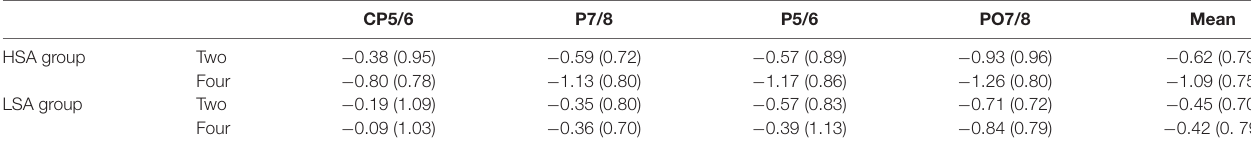
TABLE 1 | Mean contralateral delay activity (CDA) amplitudes from four pairs of electrodes.